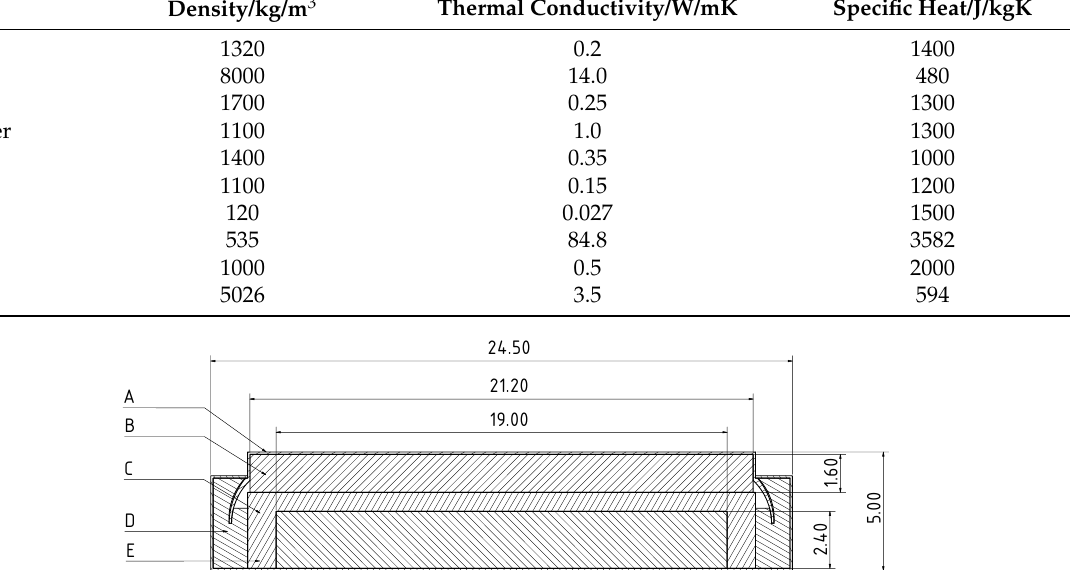
Figure 5. Cross-section through 3D coin cell model developed for simulation purposes. ( A ) steel casing, ( B ) Li anode, ( C ) separator, ( D ) gasket, ( E ) MnO 2